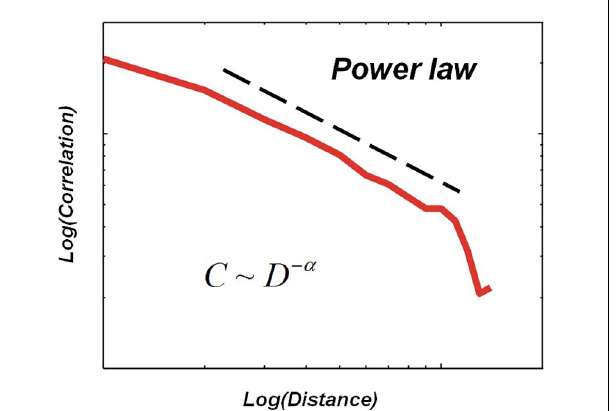
FIGURE 4 | Correlation length as a function of temperature for a simulation of the Ising Model. Near the critical temperature the correlation length rapidly approaches a maximum value.This sharp peak separates the ordered phase from the disordered phase and occurs at the phase transition point.